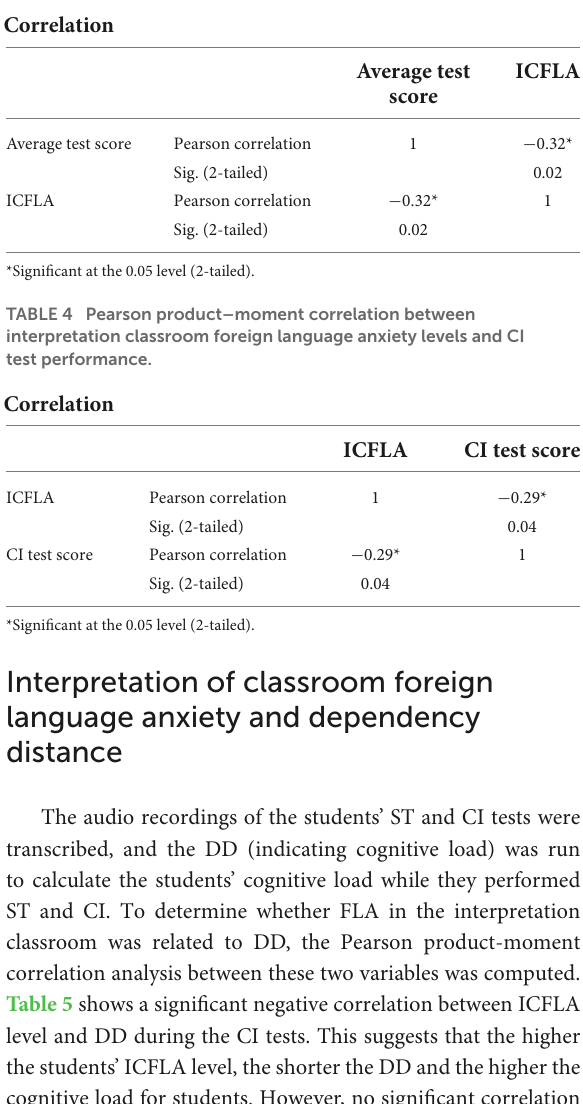
TABLE 3 Pearson product–moment correlation between interpretation classroom language anxiety levels and average test score at a Hong Kong tertiary institution.